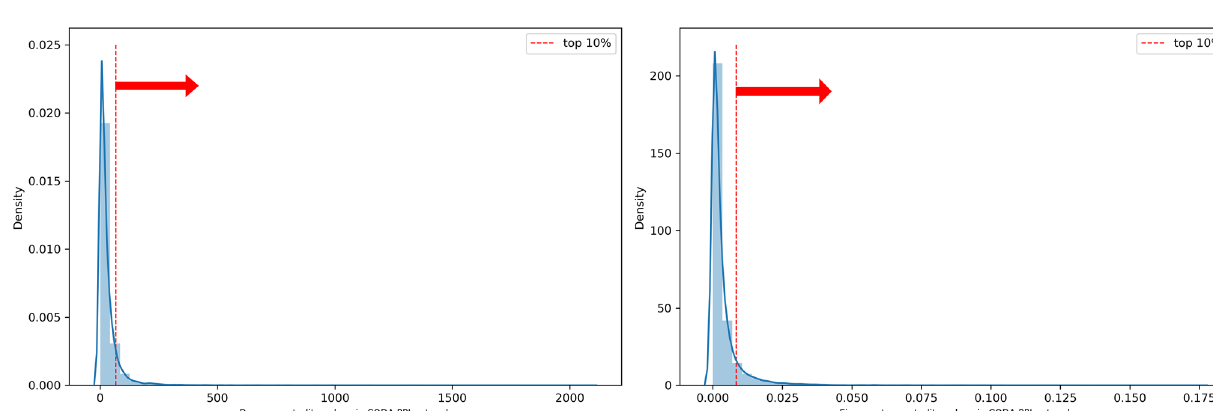
Figure 5. ( a ) PPI network constructed with CODA. ( b ) Network of hub predicted target genes.